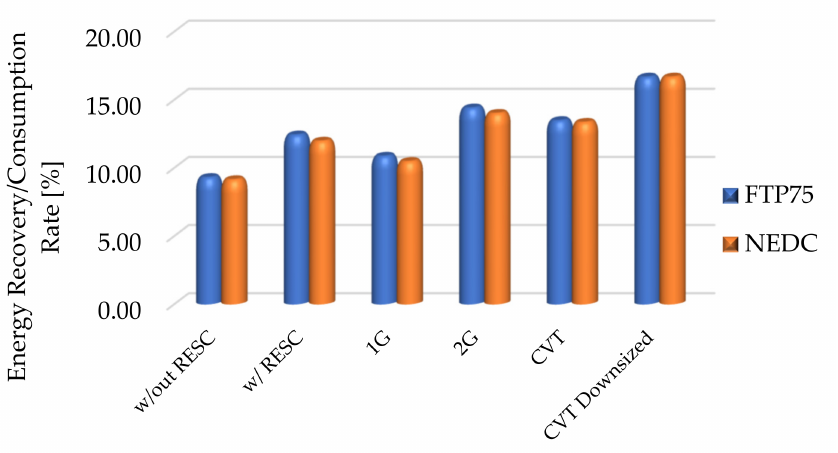
Figure 16. Comparison of energy recovery/consumption